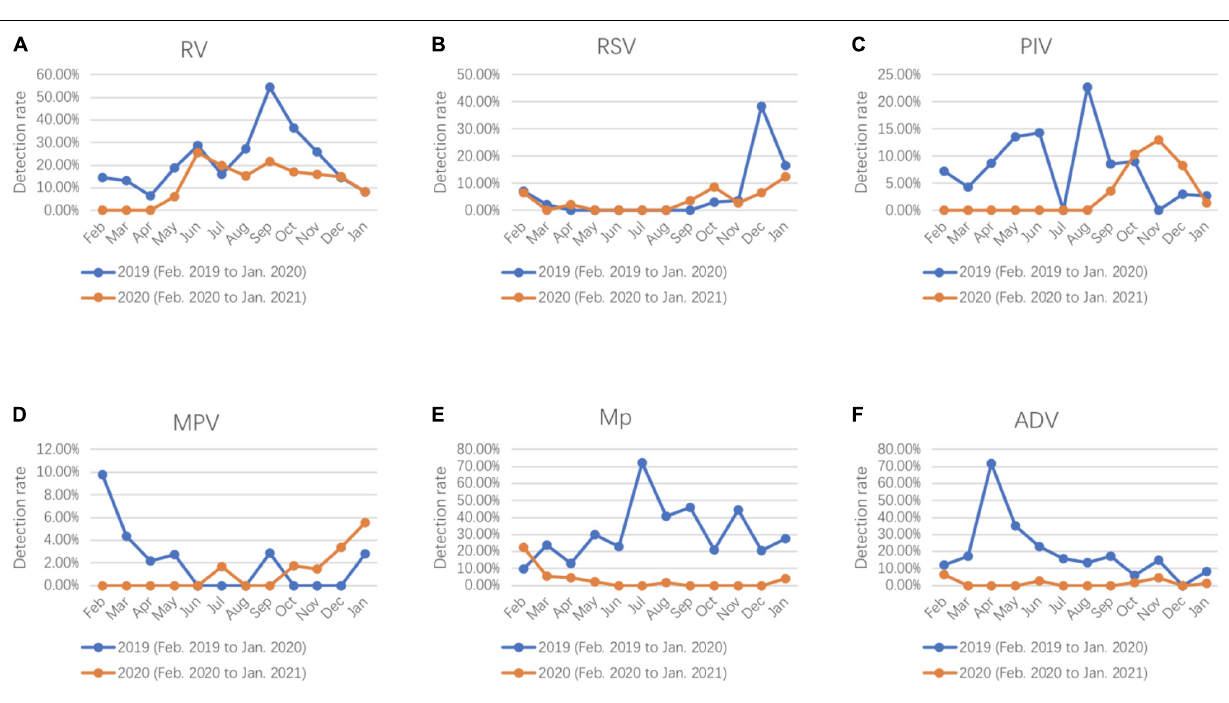
FIGURE 2 | Seasonal activity of respiratory pathogens (A) RV, (B) RSV, (C) PIV, (D) MPV, (E) Mp, and (F) ADV detected in hospitalized patients with lower respiratory tract infections (LRTIs) during the year of 2020 (February 2020 to January 2021) compare with the year of 2019 (February 2019 to January